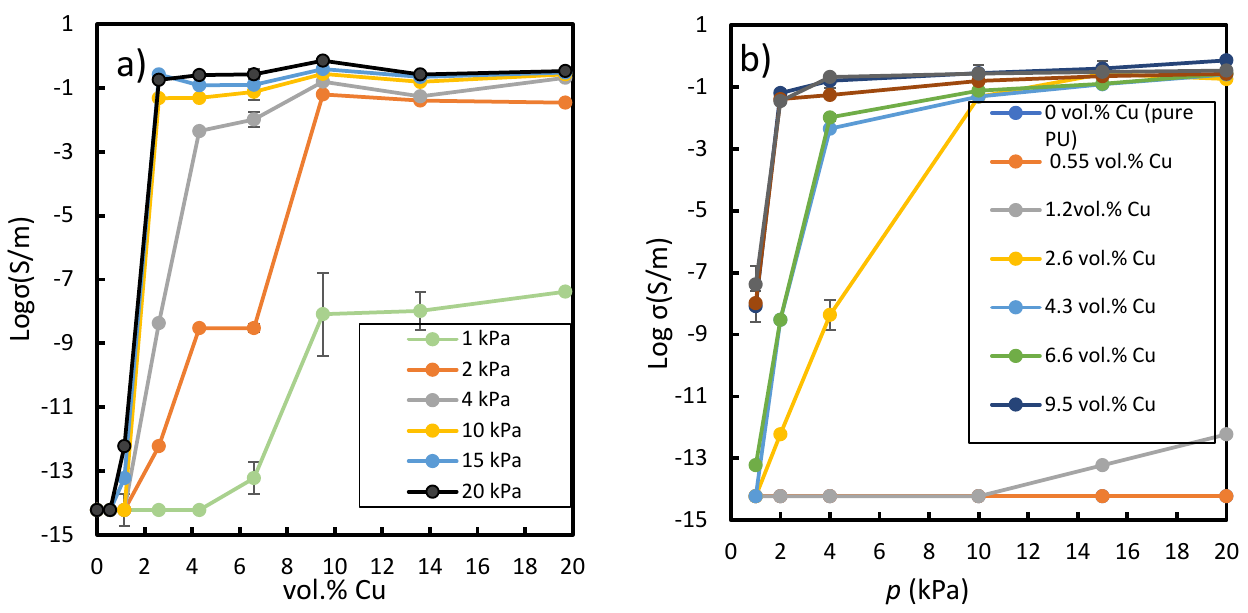
Figure 8. ( a ) Electrical conductivity vs. concentration of Cu for the different pressures (1–20 kPa), and ( b ) electrical conductivity vs. applied pressure for different concentrations of Cu particle in volumetric percent. In b), it should be noted the dark blue line-symbols for 0 vol % Cu is overlapped with orange line-symbols for 0.55 vol % Cu